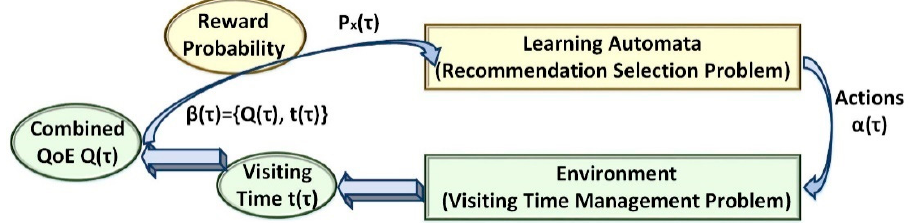
Figure 1. Joint Recommendation Selection and Visiting Time Management (RSVTM) framework as a learning system.